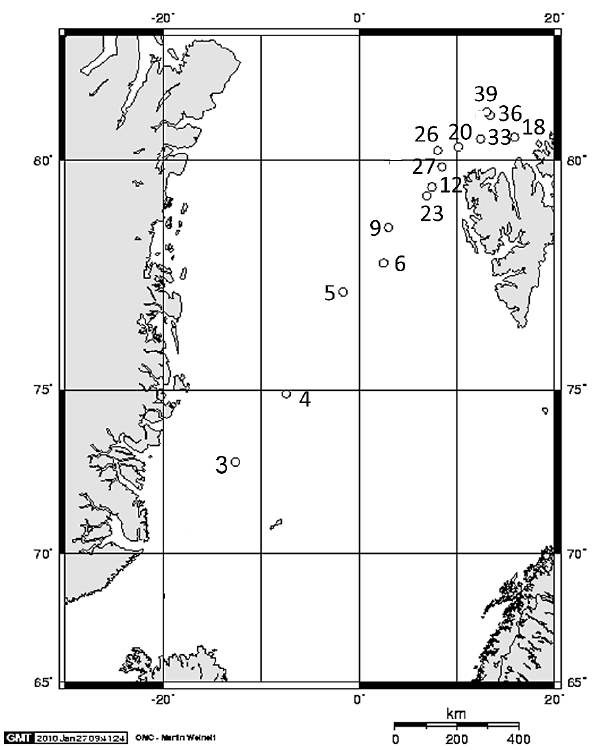
Fig. 1. Map of the study area and position of the sampled